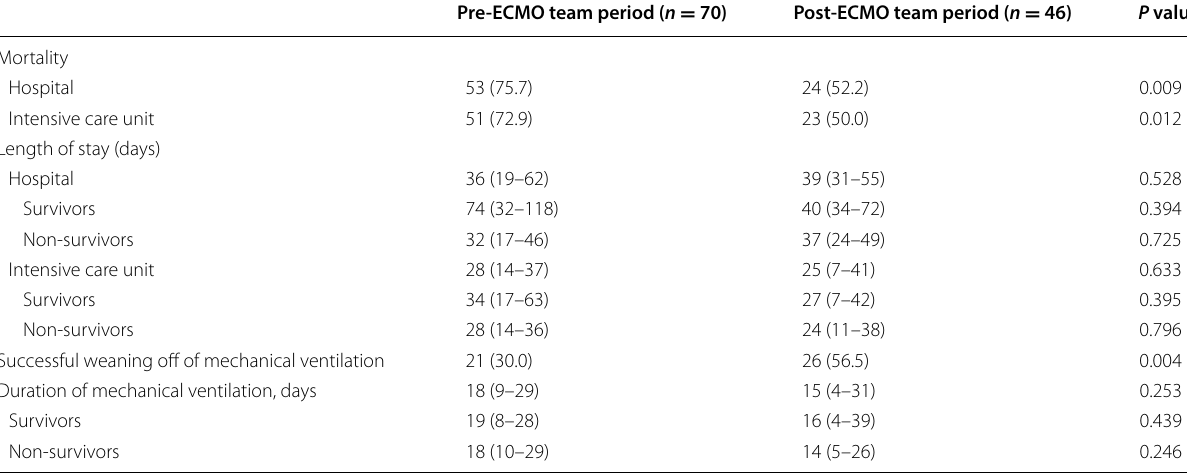
Values are given as the median (interquartile range) or n (%) ECMO indicates extracorporeal membrane oxygenation